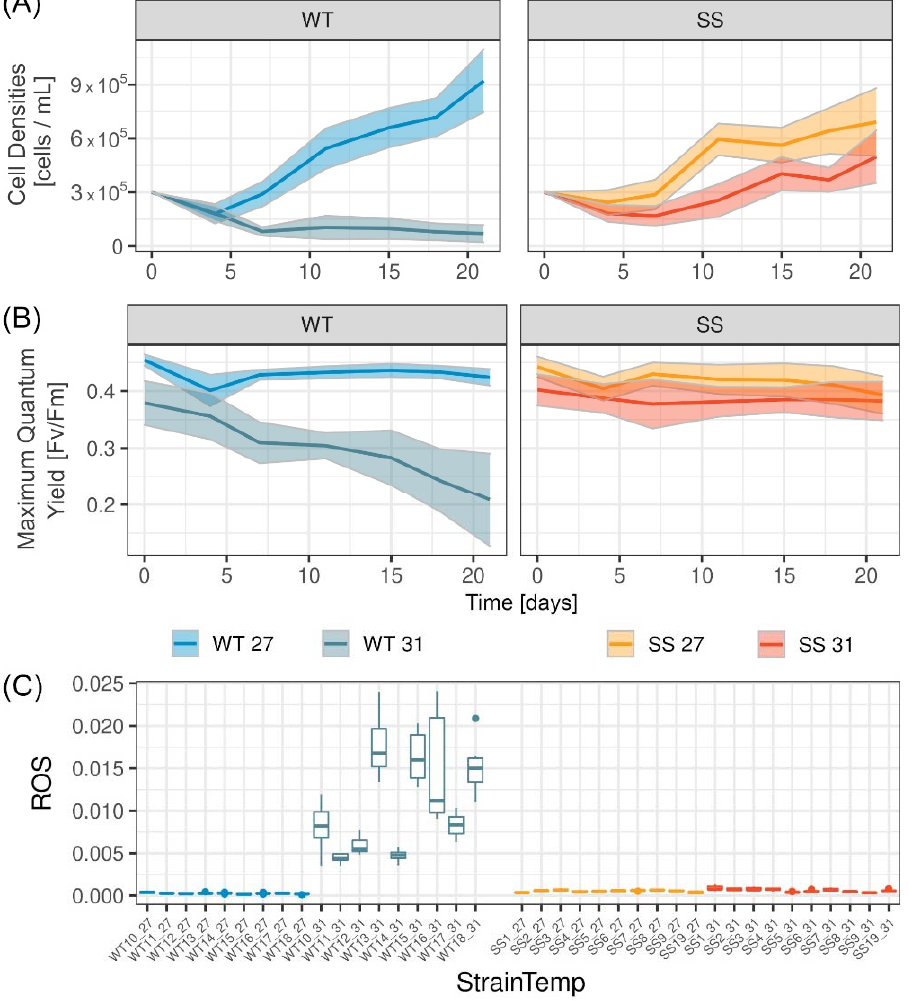
Figure 1. Physiological performance of wild-type and heat-evolved strains. ( A ) Cell densities [cells/mL] ( B ) maximum quantum yield [Fv/Fm] are shown with standard deviations from the mean. ( C ) Extracellularly measured reactive oxygen species (ROS) [arbitrary fluorescence unit] at day 21 is shown for the strain groups wild-type (WT) and the heat-evolved strain (SS) at both temperatures (27 °C and 31 °C).